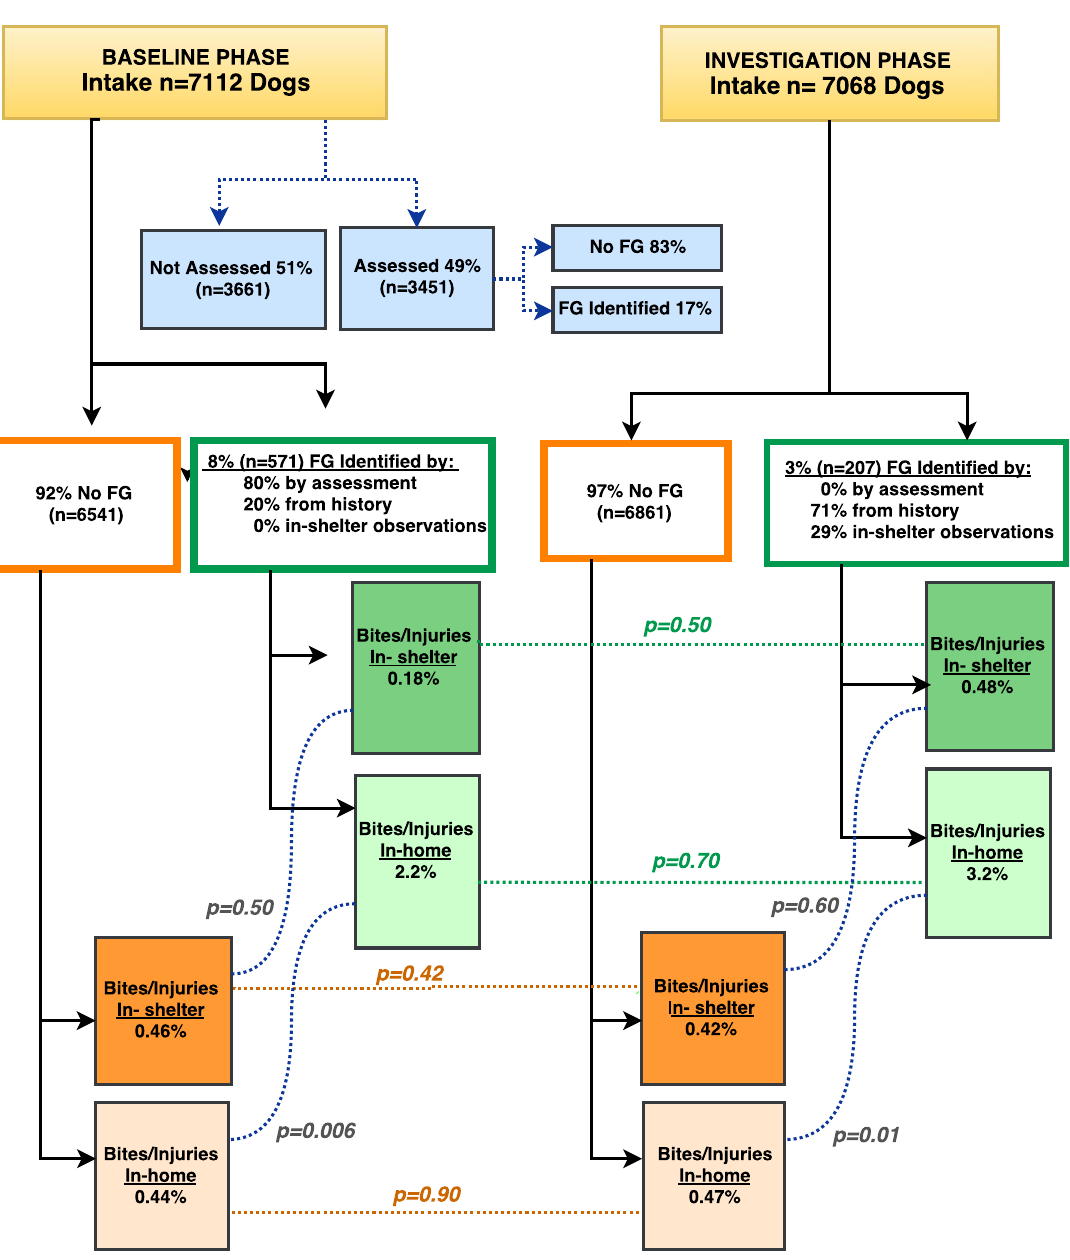
Figure 1. Total intake of dogs between the two study phases: percentage of dogs who were assessed, those dogs identified with food guarding behavior, and incidence of injury/bites in each phase. Non-FG groups are in orange and food guarding (FG) groups in green, with corresponding p -values displayed between the baseline and investigative phases. In baseline phase, there are blue boxes and dotted lines that show the percentage of dogs that had the standardized shelter assessment and of those assessed, how many were identified with FG. This was added so the reader can visualize the large percentage of dogs that did not have a standardize assessment performed and to clarify the two ways a shelter can arrive at incidence of FG (17% is only of those assessed while 8% is all